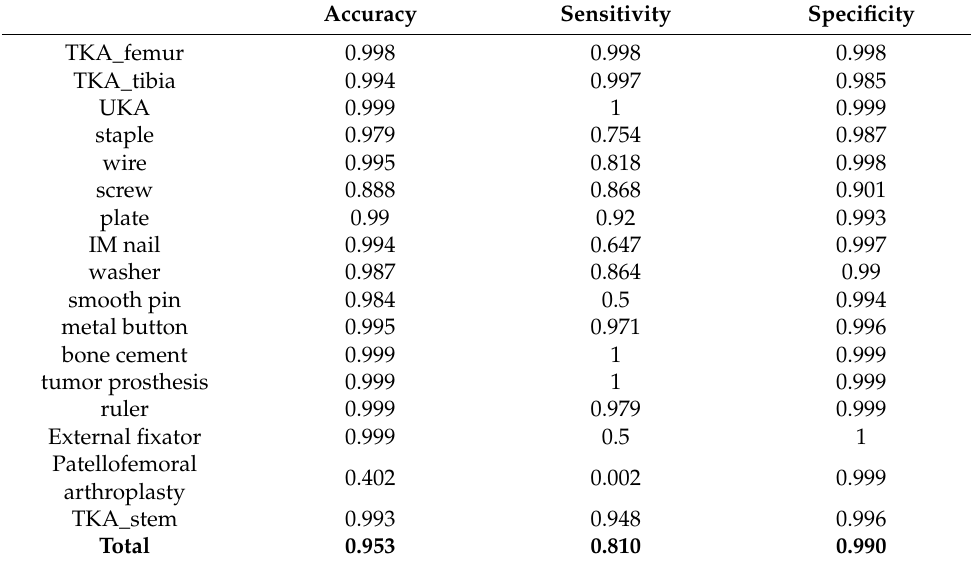
Table 3. Evaluation metrics on the internal test set.